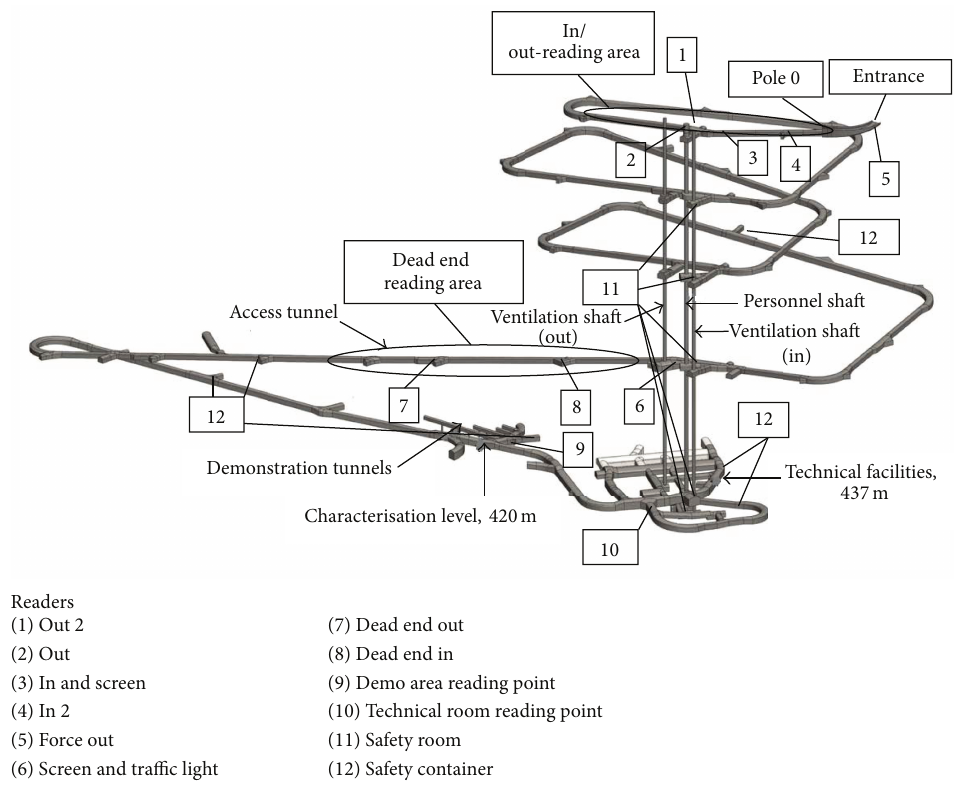
Figure 2: The reading points and reading areas in ONKALO.